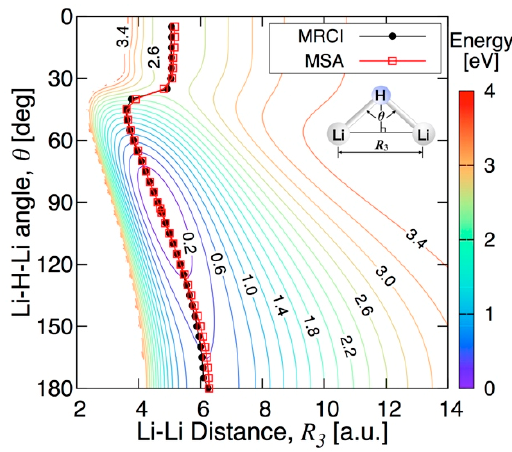
Figure 11. Energy contours of the insertion of H into Li 2 in C 2v symmetry. The energy contours are